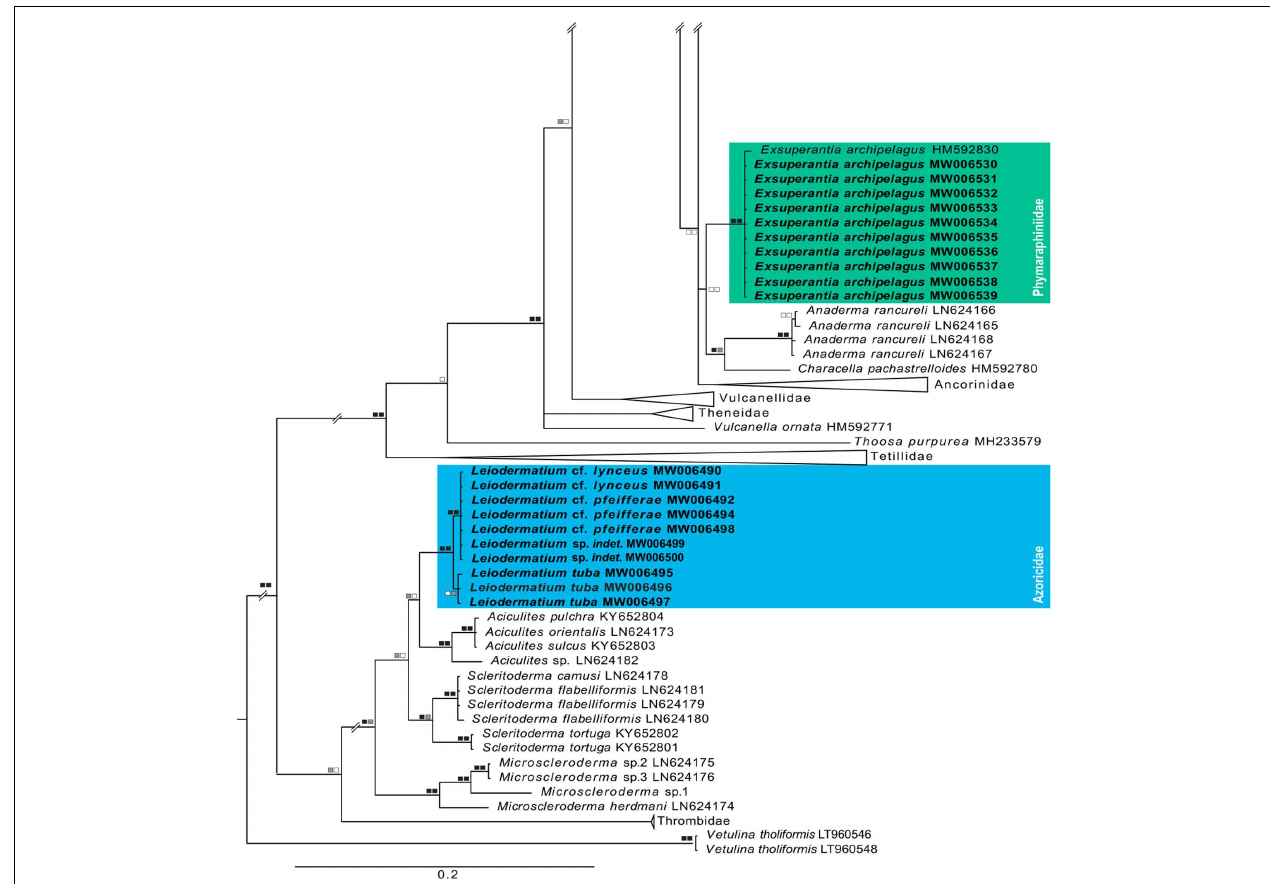
FIGURE 6 | Phylogenetic reconstruction of the 28S rRNA C1–D2 region for lithistids recorded in the Azores archipelago. Bayesian posterior probabilities (PP, left square) and maximum likelihood bootstrap support (BS, right square) values are given on the branches. If only one square is shown, it means the clade was not retrieved in the Maximum Likelihood analysis. Sequences generated in this study are in bold. Families encompassing lithistid species found in the present study are highlighted in